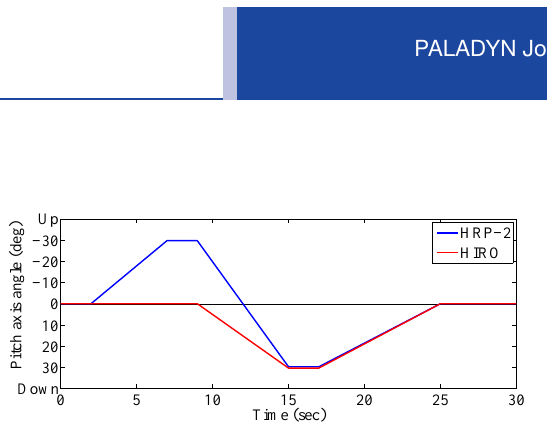
Figure 13. Pitch-axis motion trajectory for two robots